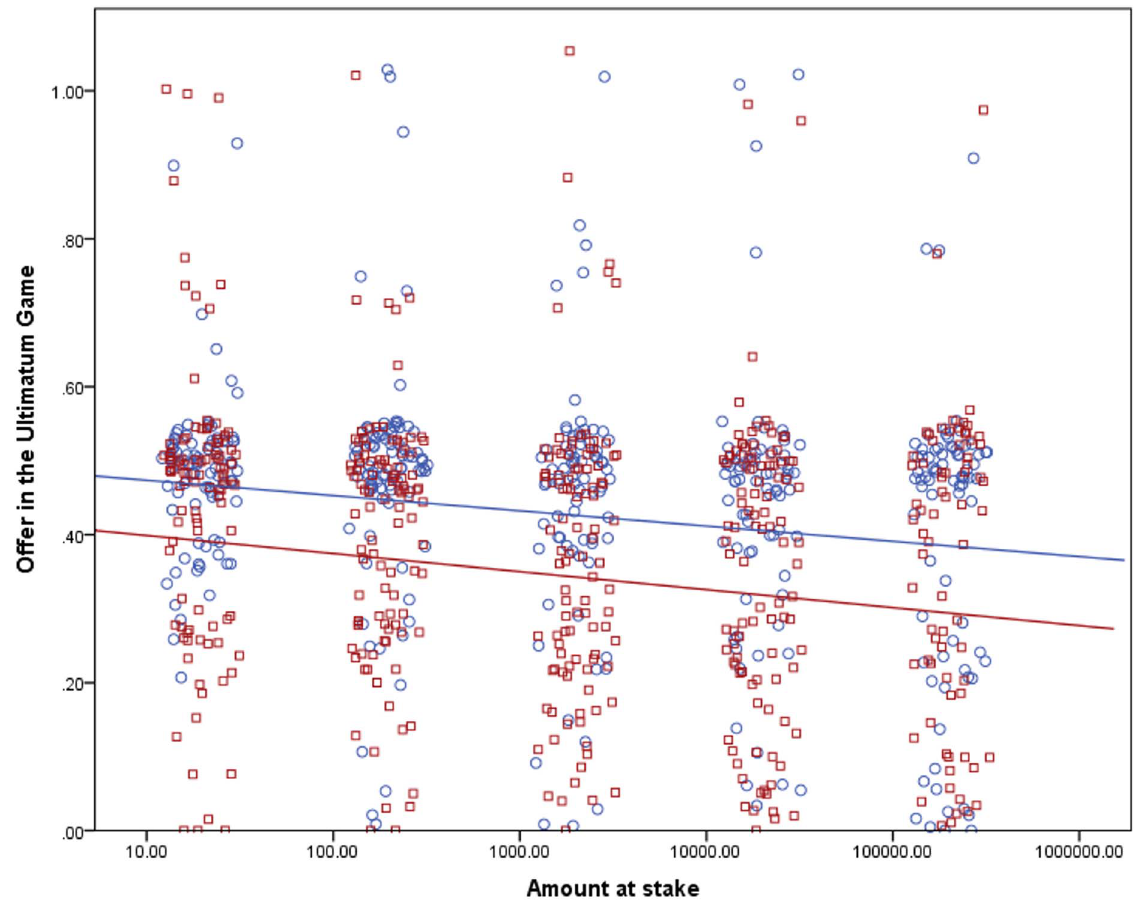
Figure 2. Effect of the amount at stake on the relative proposed shares in the UG. The stakes are shown on a logarithmic scale and are in CZK. The points were jittered to be better visible in their numbers. Treatment One, where the subjects only answered questions for one amount at stake, is marked with circles and the color of the points and the regression line is blue. The estimated effect size for the influence of the stakes on the shares in Treatment One is 3.2%. Treatment Five, where the subjects answered questions for all five amounts, is marked with squares and it has red points and the regression line. The estimated effect size for the influence of the stakes on the shares in Treatment Five is 3.0%.